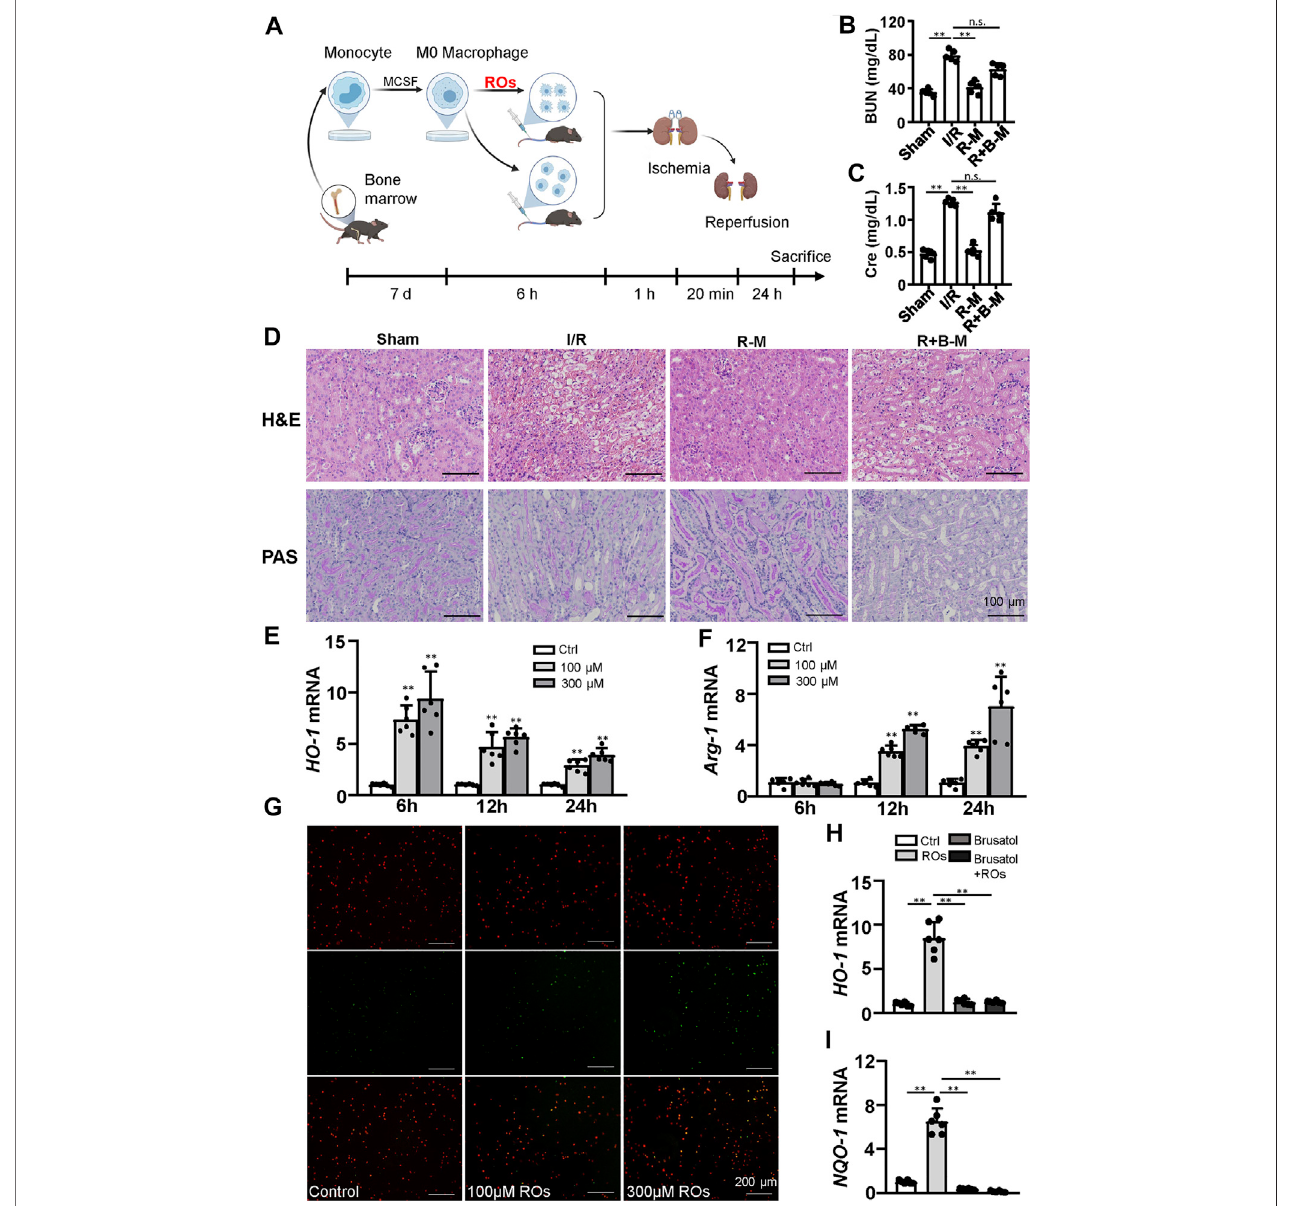
FIGURE 6 | Macrophages mediate the renoprotective effects of riclinoctaose. (A) Schematic diagram of bone marrow-derived macrophages (BMDMs) injection strategy. BMDMs were isolated from femurs and tibias, polarized for 7 days, and stimulated with vehicle or riclinoctaose for 6 h. Then, treated BMDMs were injected intravenously 1 h before 20 min of bilateral ischemic, and mice were sacri fi ced at 24 h post-reperfusion. (B, C) Blood urea nitrogen (BUN) levels and serum levels of creatinine (Cre) in sham mice, mice injected with vehicle-treated BMDMs (I/R), mice injected with riclinoctaose-treated BMDMs (R – M), and mice injected with riclinoctaose and brusatol-cotreated BMDMs (R + B-M). (D) Upper panel: representative kidney section stained for hematoxylin and eosin in each mice group. Lower panel: representative kidney section stained with Periodic acid – Schiff in each mice group. (E, F) HO-1 and Arg-1 mRNA expression levels of BMDMs treated with riclinoctaose(100and300 μ M)atdifferenttimepoints. (G) BMDMs(red)treatedwithvehicleorriclinoctaosefor6 hwereincubatedwithapoptoticthymocytes(green)for 30 min, and the percent of phagocytized thymocytes was determined by fl uorescent microscopy. (H, I) mRNA expression levels of HO-1 and IL-10 in BMDMs treated with riclinoctaose or brusatol alone or co-treated with riclinoctaose and brusatol. Ctrl: Control, ROs: Riclinoctaose. Data are expressed as mean ± SD. n (cid:1) 6, * p < 0.05, ** p < 0.01, n. s. nonsigni fi cant. Data were analyzed by the two-way ANOVA followed by Bonferroni post hoc analysis.